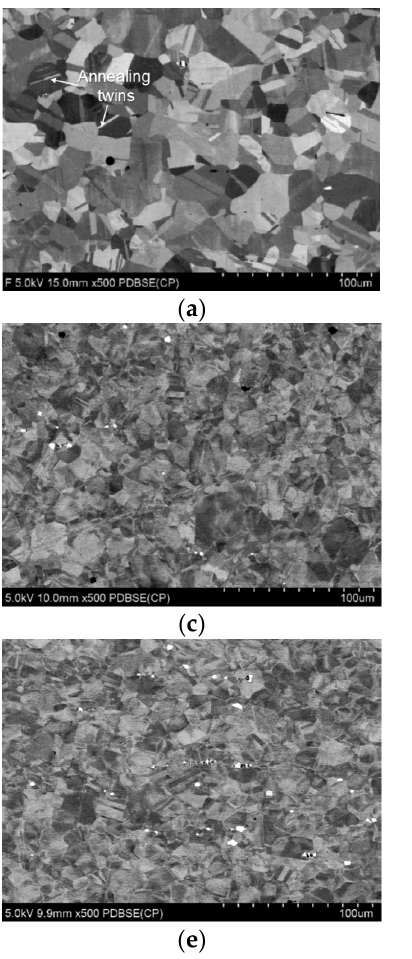
Figure 7. SEM images of the test material microstructure ( a ) cross section, ( b ) longitudinal section. SEM images of the microstructure of the material after deformation taken ( c ) from zone Z1 , ( d ) zone Z3 , and ( e ) zone Z5 .